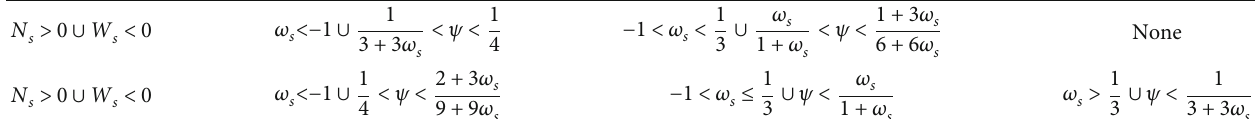
Table 1: The positive values of critical points in the case of ρ